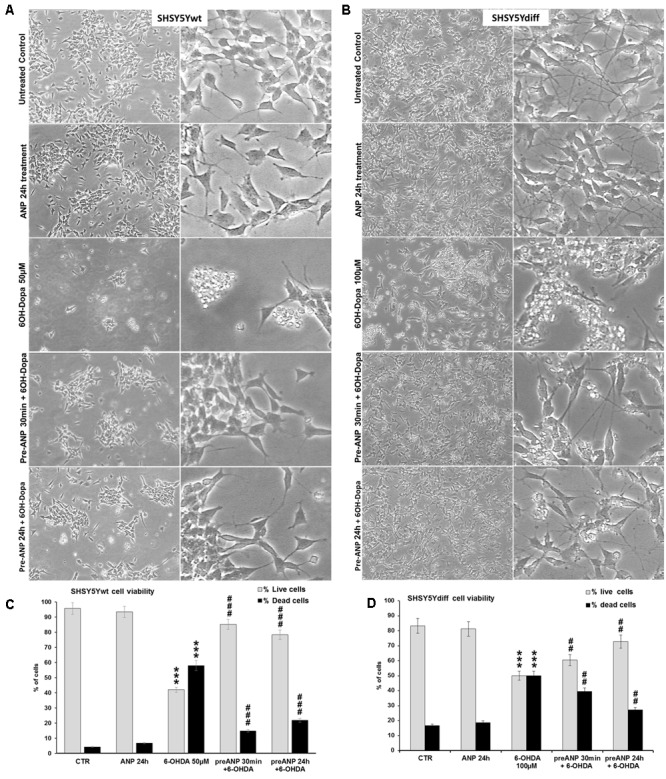
Atrial natriuretic peptide pre-treatment prevents 6-OHDA toxicity on SHSY5Ywt and SHSY5Ydiff cells. (A,B) Phase contrast microscopy of SHSY5Ywt (A) and SHSY5Ydiff (B) cells exposed to 50 and 100 μM of 6-OHDA, respectively, for mimicking the neurodegeneration of PD. To verify the ability of ANP in preventing the 6-OHDA induced cytotoxicity, cells were pre-treated with 100 nM of the natriuretic peptide, 30 min or 24 h prior to 6-OHDA addition to cell culture medium. Original magnification: left panels: 10x; right panels: 20x. (C,D) Cell viability assay performed on SHSY5Ywt (C) and SHSY5Ydiff (D) cells after 24 h of 6-OHDA treatment by Trypan blue dye exclusion method; results, reported as percentage of live/dead cells, are mean of three independent experiments. ∗Significance vs untreated control (Ctr); #Significance vs 6OH-Dopa: ∗p < 0.05; ∗∗p < 0.01; ∗∗∗p < 0.001; the mean ± SD; n = 3.